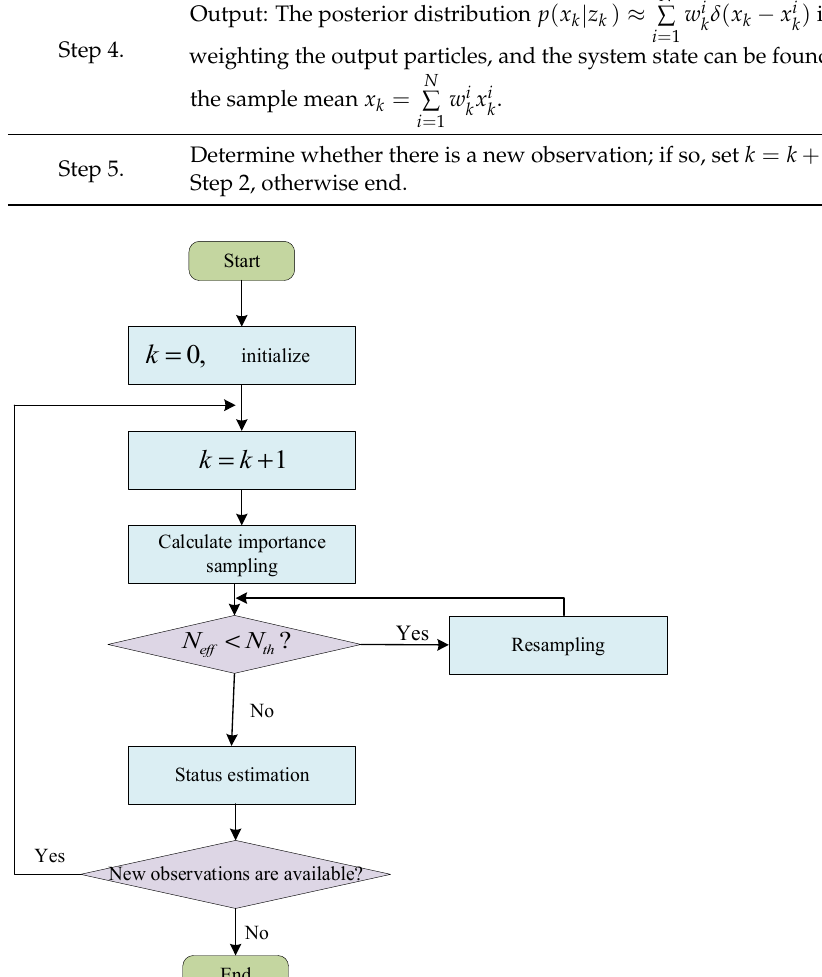
Figure 4. Flow chart of standard PF algorithm.